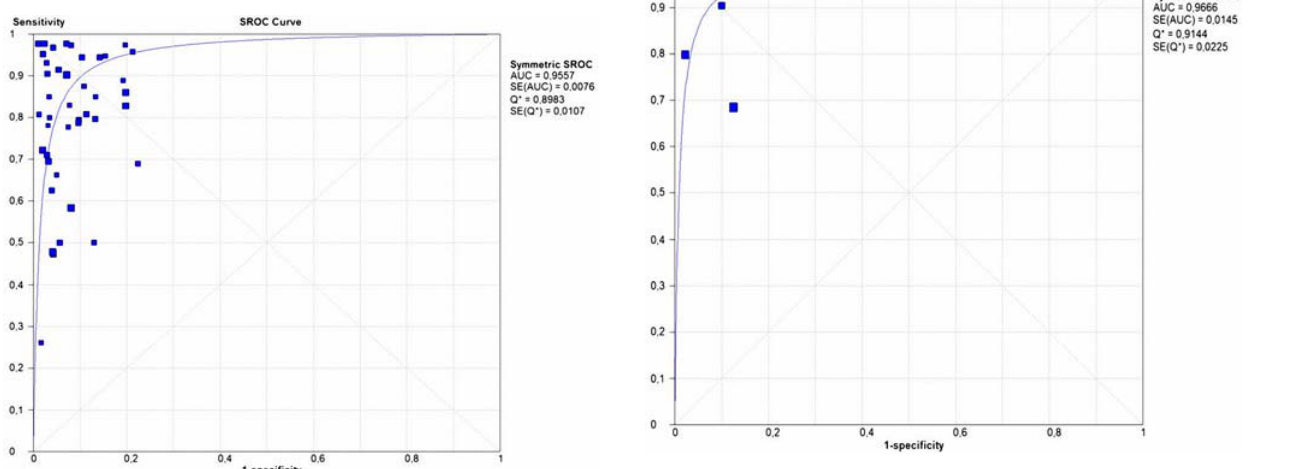
Figure 4. Forest Plot for the Sensitivity and Specificity of the Western Blot Diagnostic Tests. The squares and lines represent the point estimates and 95%CIs, respectively. The size of square indicates the study size. The pooled estimated is denoted by a diamond at the bottom. a=HelicoBlot 2.0, b=HelicoBlot 2.1, c=HelicoBlot 2.1 CIM; d=In- house